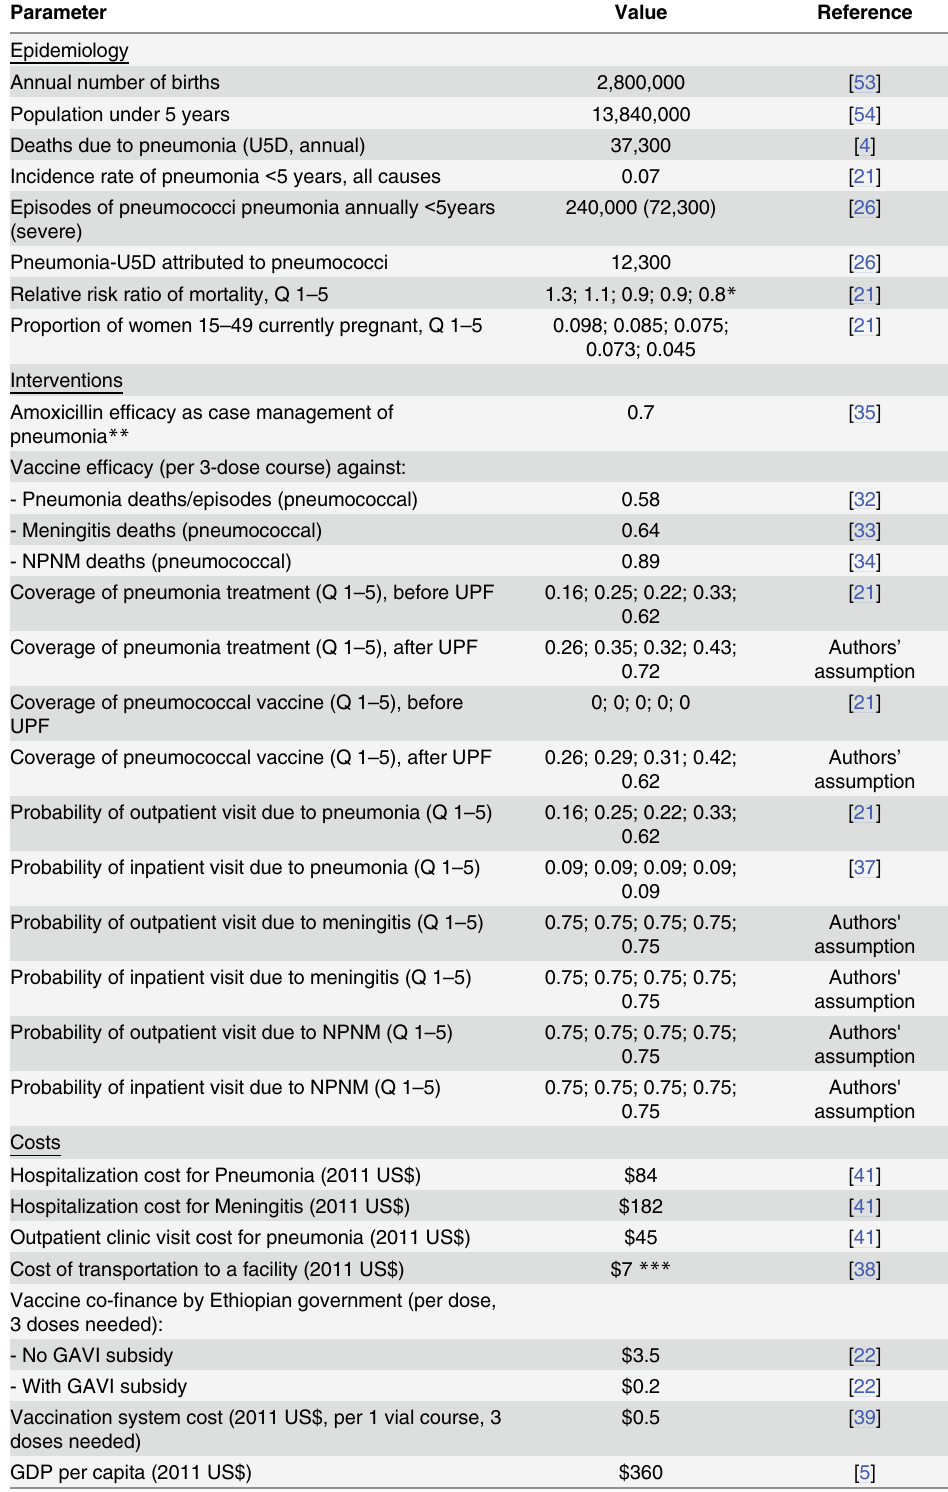
Table 1. Parameters used for the economic evaluation of universal public finance (UPF) for pneumo- coccal vaccination and pneumonia treatment in